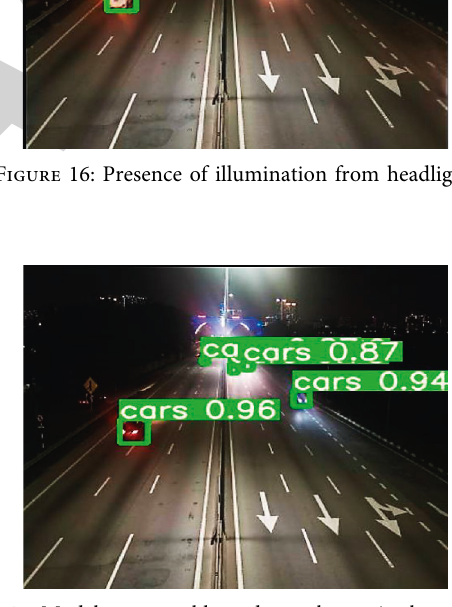
Figure 17: Model was not able to detect the car in the nonlighted area.